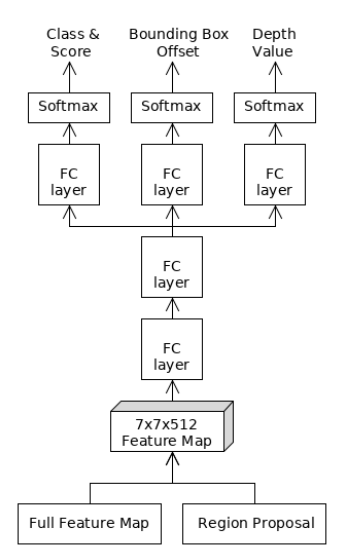
Figure 9. LoD3 building models with windows, visualized with Azul CityGML viewer.